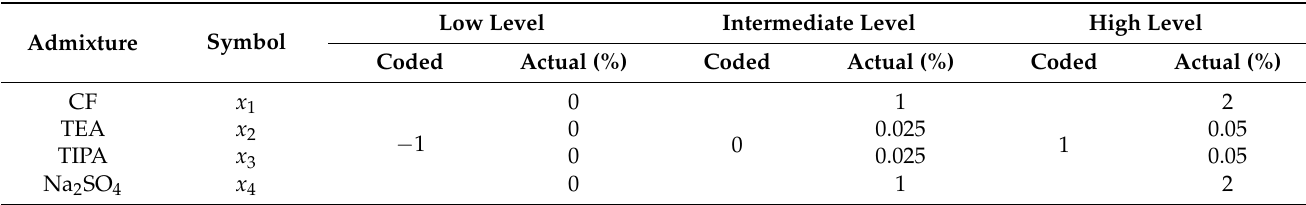
Table 2. Actual contents and coded numbers of admixtures.